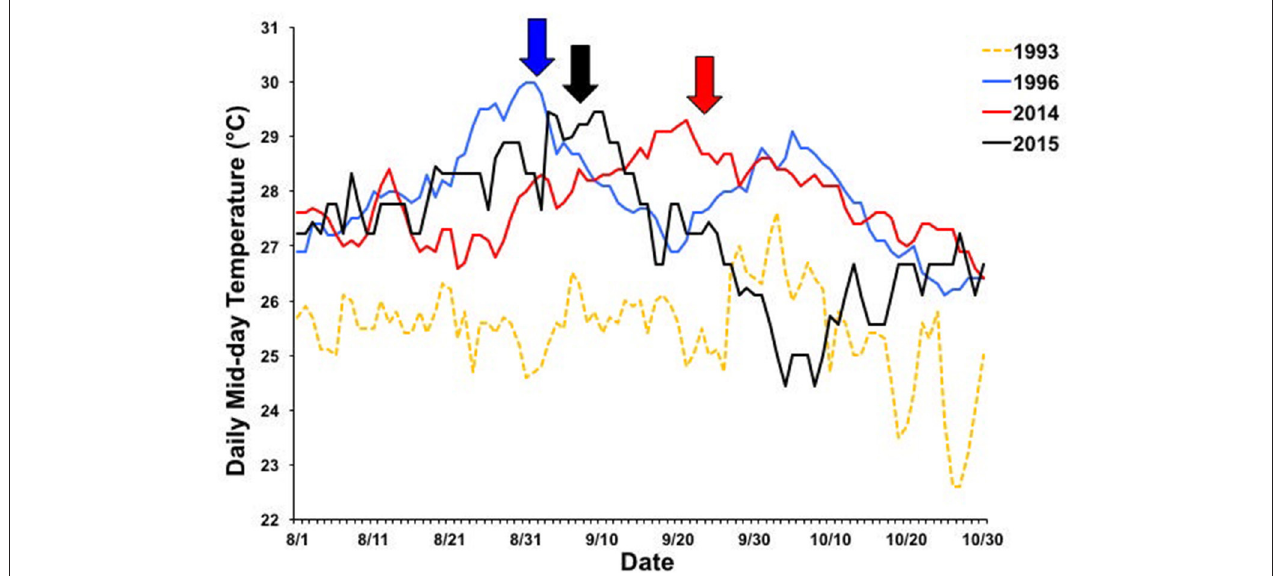
FIGURE 8 | Seasonal timing of 1996 (blue), 2014 (red), and 2015 (black) bleaching events. Daily mid-day (11:00–14:00) temperatures between 1 Aug and 1 Nov are shown for each year. Temperature data from 1993 is included as a non-bleaching reference year (yellow, dashed line). Arrows indicate when bleaching began. Temperature data collected from Hawai‘i Institute of Marine Biology Weather Station (http://www.pacioos.hawaii.edu/weather/obs-mokuoloe).